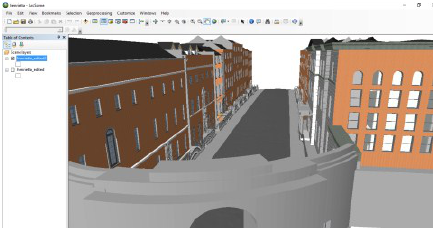
Figure 9: SketchUp model with materials displayed in ArcScene